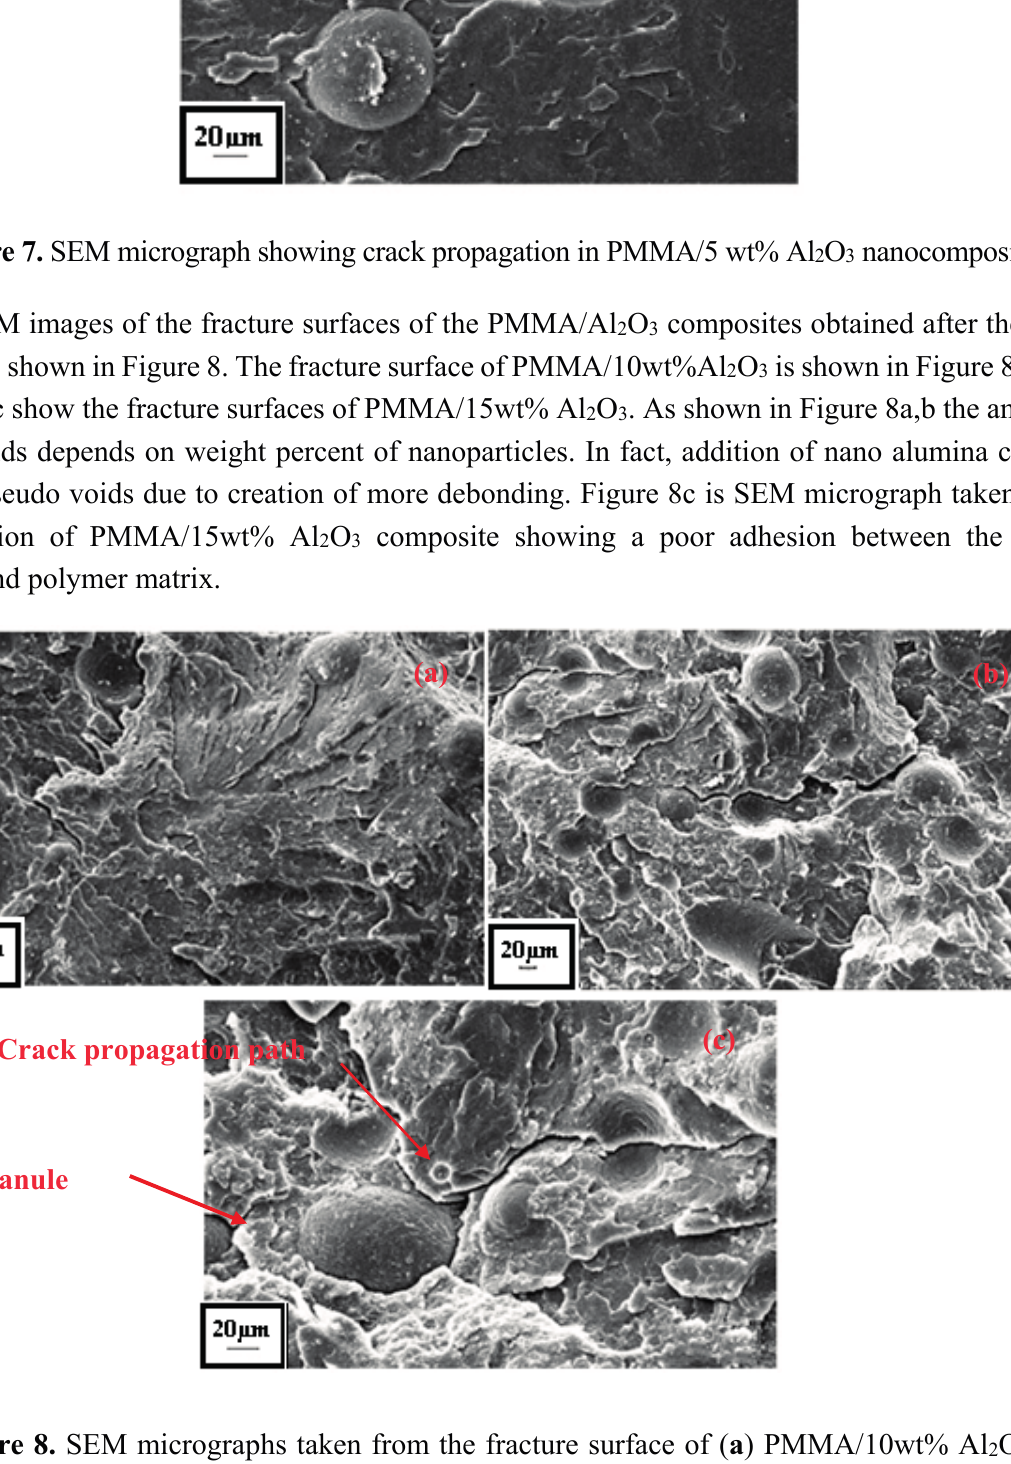
Figure 8. SEM micrographs taken from the fracture surface of ( a ) PMMA/10wt% Al 2 O 3 ; ( b , c ) PMMA/15wt% Al 2 O 3